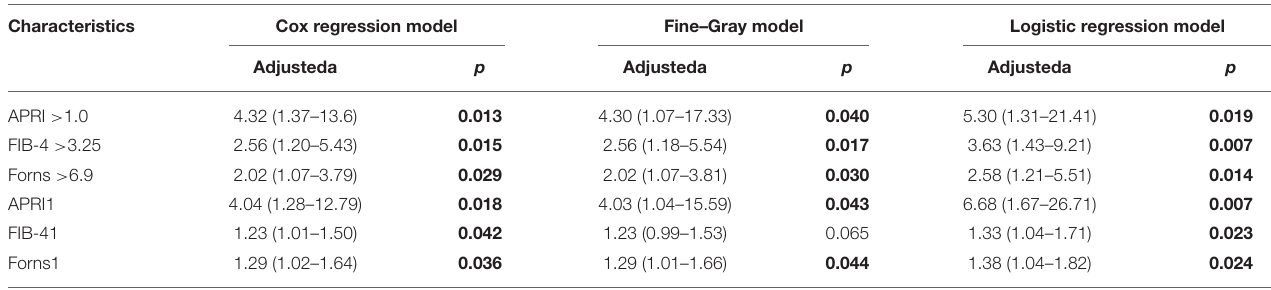
TABLE 3 | Associations between liver fibrosis scores and recurrence in patients with CSDH. Characteristics Cox regression model Fine–Gray model Logistic regression model Adjusteda Adjusteda